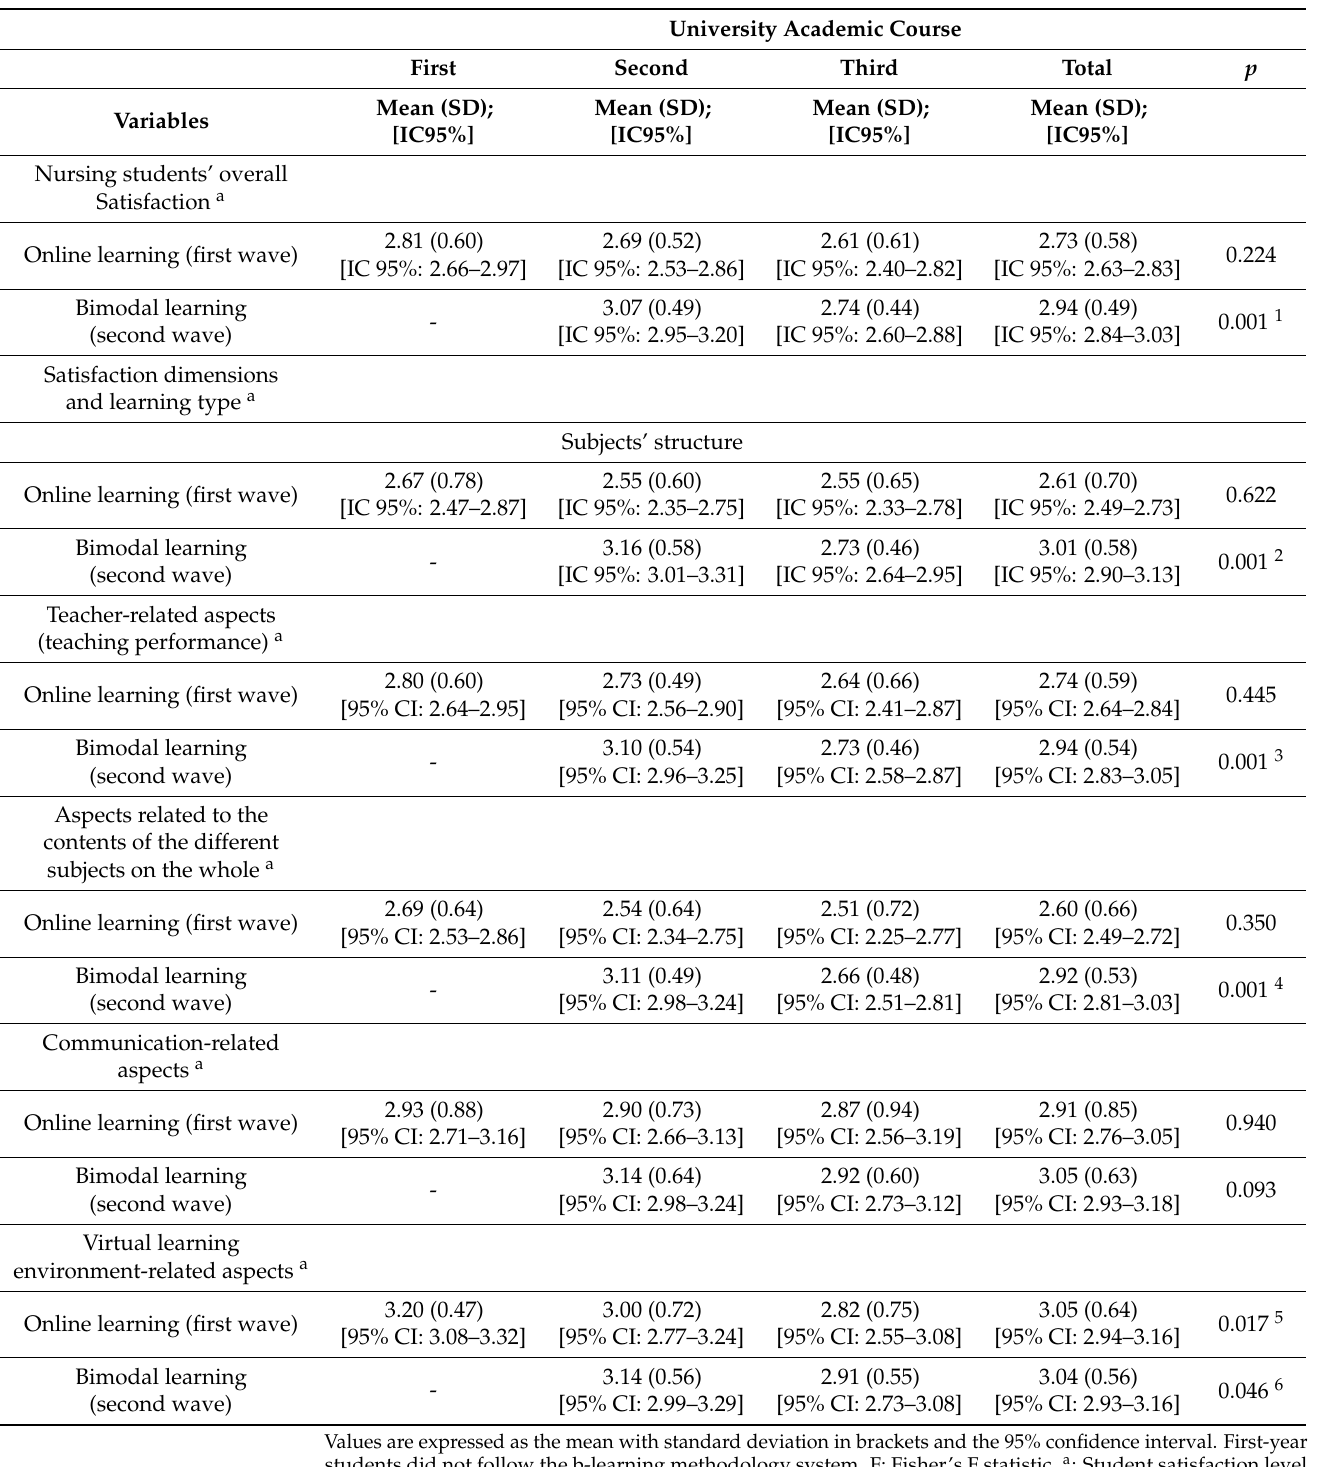
Table 4. Nursing student satisfaction with online and bimodal learning per course measured with the adapted CUSAUF questionnaire. Bivariate